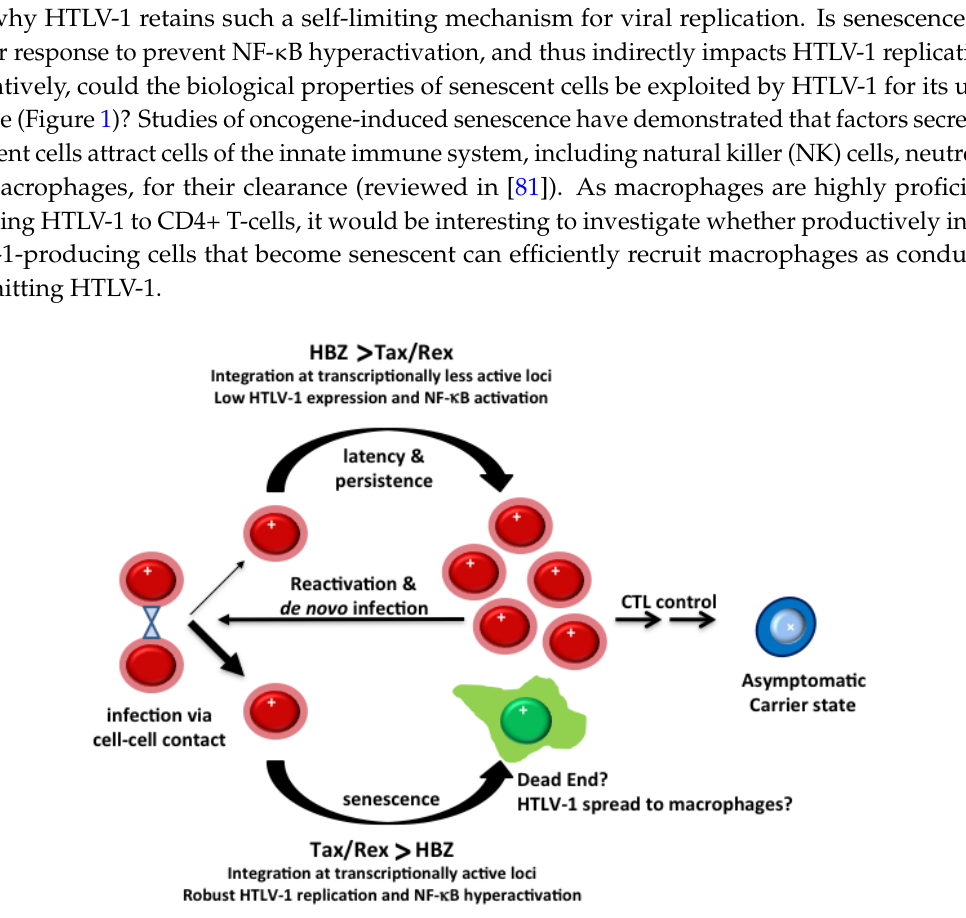
Figure 1. Outcomes of HTLV-1 (Human T-cell lymphotropic virus type 1) infection. Proviral